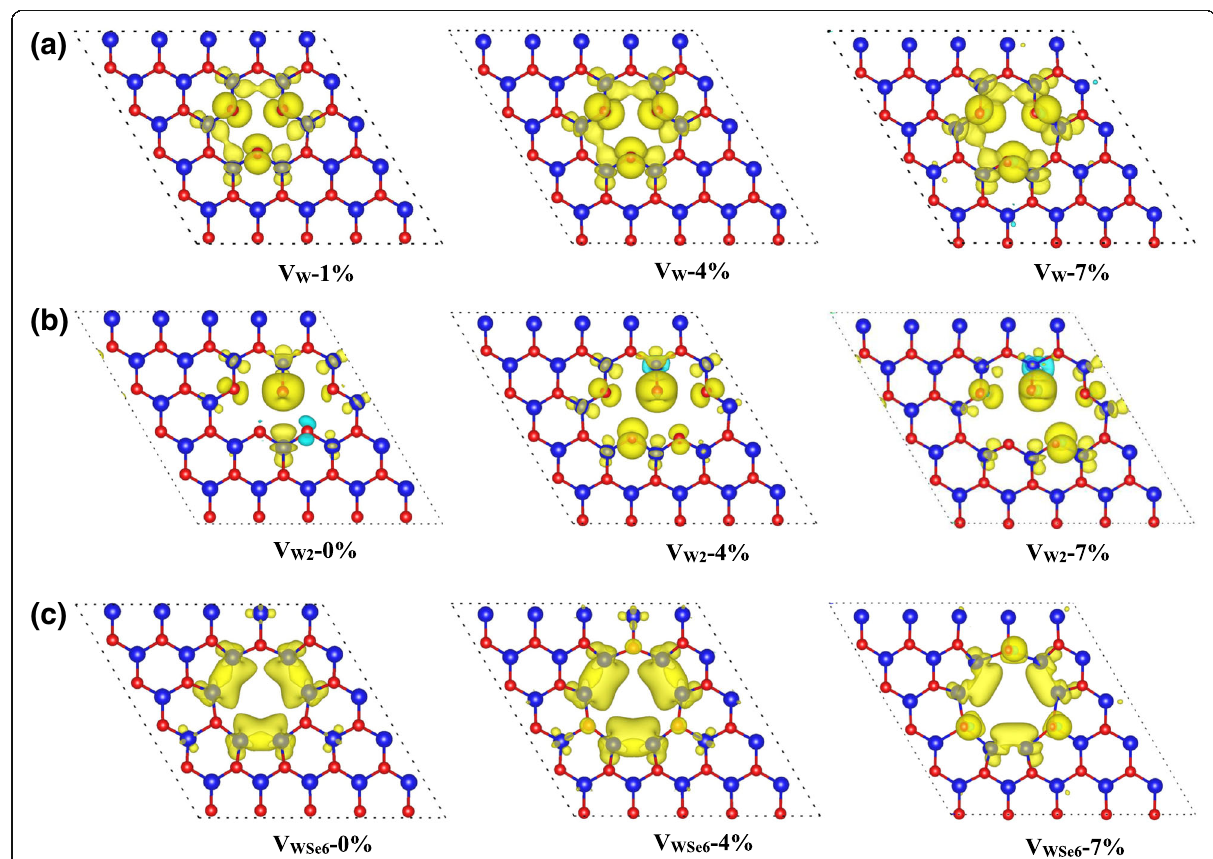
Fig. 7 Spin-resolved charge density of monolayer WSe 2 with a V W , b V W2 , and c V WSe6 vacancies under the tensile strain of 0~7%. Yellow and cyan isosurfaces represent the positive and negative spin densities,